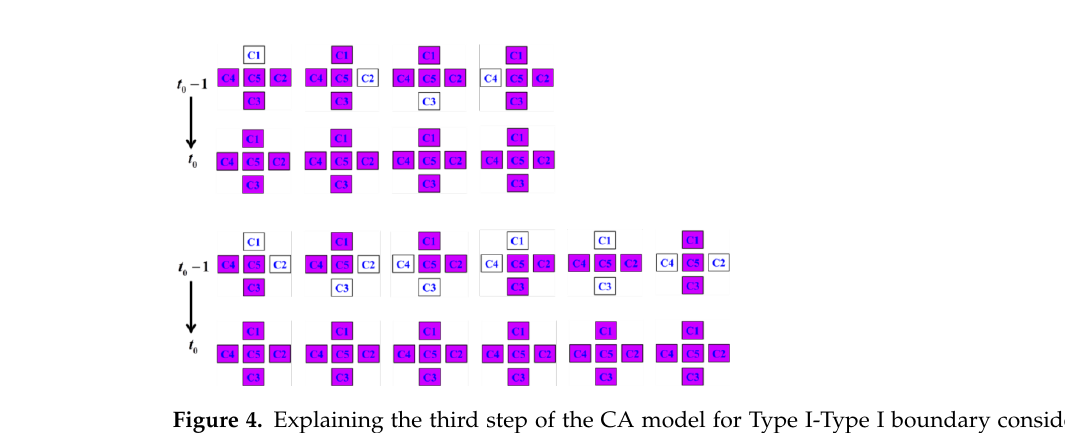
Figure 6. The linear relationship between the radius of the secondary grain and time. 7.0x10 6